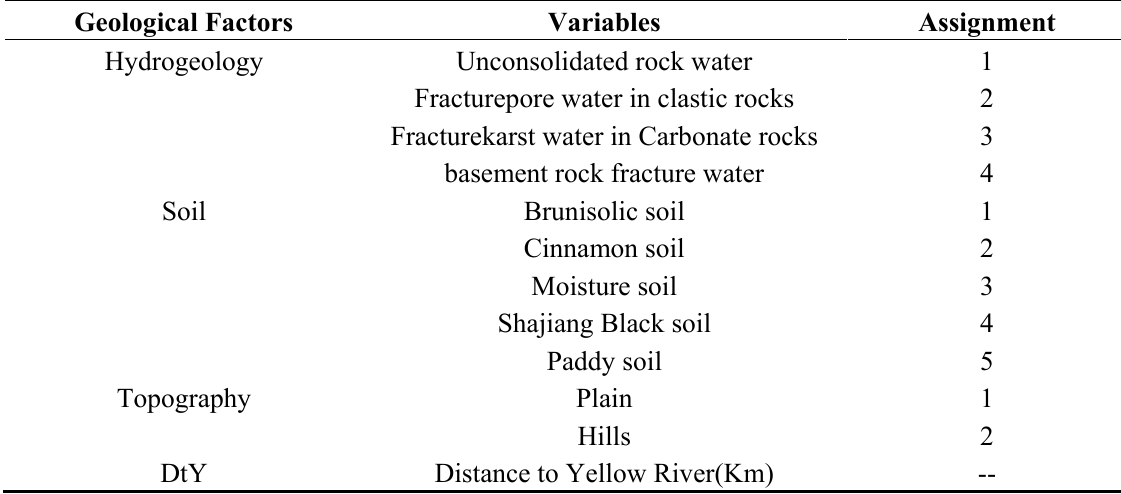
Table 1. Value assignment of the geological